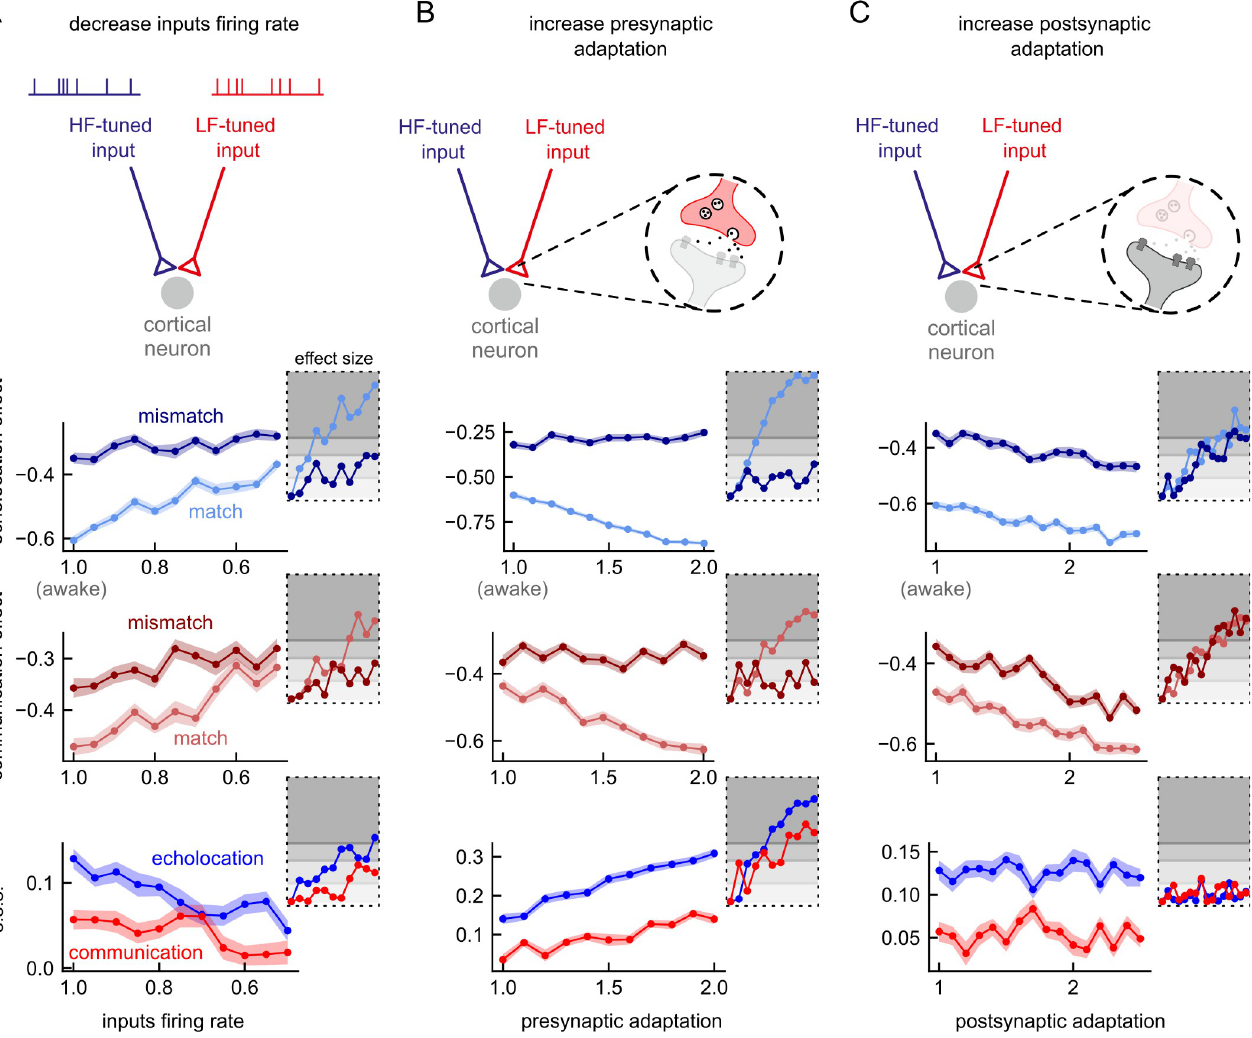
Fig 2. Effects of anaesthesia on a model for acoustic context effects on cortical neuron responses to natural sounds. Diagrams on top illustrate possible effects of KX on a neuron model that explains acoustic context effect in the AC of awake bats [23]. ( A ) The decrease of the cortical input firing rate was implemented by systematically decreasing the average input rate parameter, ν , by a factor of 1.0 (awake model) to 0.5 in steps of 0.05. First row shows the context effect after echolocation context for each simulation ( n = 50) for the mismatching and the matching probes. Second row shows the context effect after communication context. Third row shows the stimulus-specific suppression index (s.s.s.) obtained from the same simulations after echolocation context (in blue) and communication context (in red). Insets indicate the effect size (Cliff’s delta) of each simulation for each parameter compared against the respective awake model (i.e., factor = 1.0). The different degrees of grey indicate the different interpretation of effect size: negligible, small, medium, and large. ( B ) The increment of presynaptic adaptation was implemented by systematically increasing the parameter Δ s , by a factor of 1.0 to 2.0 in steps of 0.1. ( C ) The increment of postsynaptic adaptation was implemented by systematically increasing the adaptive threshold time constant, τ th , by a factor of 1.0 to 2.5 in steps of 0.1. Note that presynaptic adaptation accentuated differences between probe-responses, while postsynaptic adaptation left them unchanged. Data supporting this figure can be found in “coefC_tau_th.npy” and “d_tau_th.npy” in “Model” folder in https://gin.g-node.org/Luciana/anesthesia_bats. The underlying codes for each panel are in file “plots.py” in the same location. LF, low-frequency; HF, high-frequency.